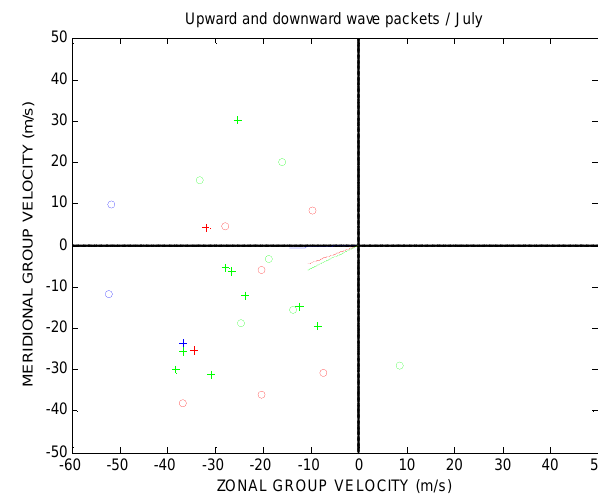
Fig.6b S ame as Fig.6a except for the month of July. Fig. 6b. Same as Fig. 6a except for the month of July.